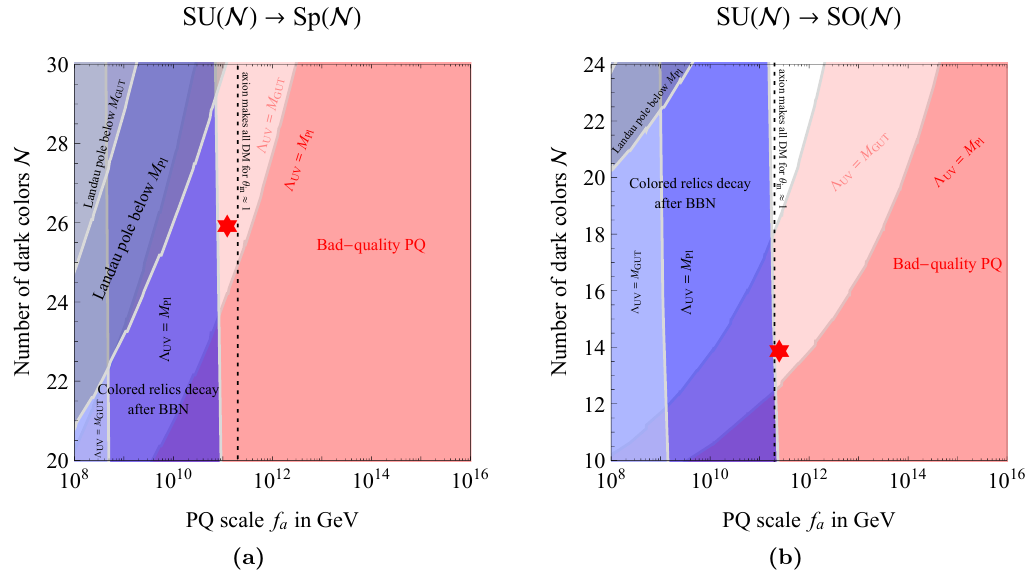
Figure 1 . Values of ( f a , N ) such that: i) the model gives rise to a high PQ-quality axion (the region shaded in red is excluded); ii) does not have sub-Planckian Landau poles for g 3 (gray is excluded); iii) colored relics decay before BBN (blue is excluded if PQ is broken after inflation). We assumed y Q = 1 = 2 y L and non-renormalizable operators suppressed by Λ UV ≈ M Pl (darker regions) or M GUT ≈ 2 10 16 GeV (lighter regions). N should be understood as an integer parameter (even integer for the left-hand plot). Left : model with a scalar in the anti-symmetric. Right : model with a scalar in the anti-symmetric. The stars indicate the models considered in figure 3, 5, that satisfy all the bounds. They lie around the vertical dashed line, where axions with initial θ i ∼ 1 make all